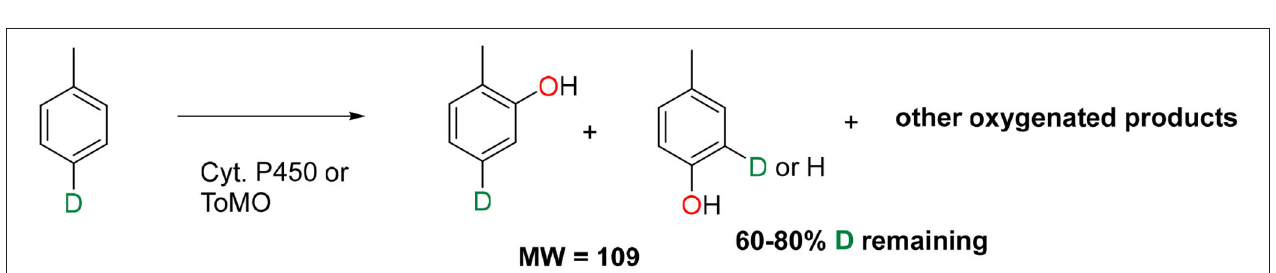
FIGURE 2 | The para -hydrogen/deuterium in [4- 2 H 0,1 ]toluene can be activated by metalloprotein via 1,2-hydride shift after OAT to have significant deuterium remaining in the p -cresol